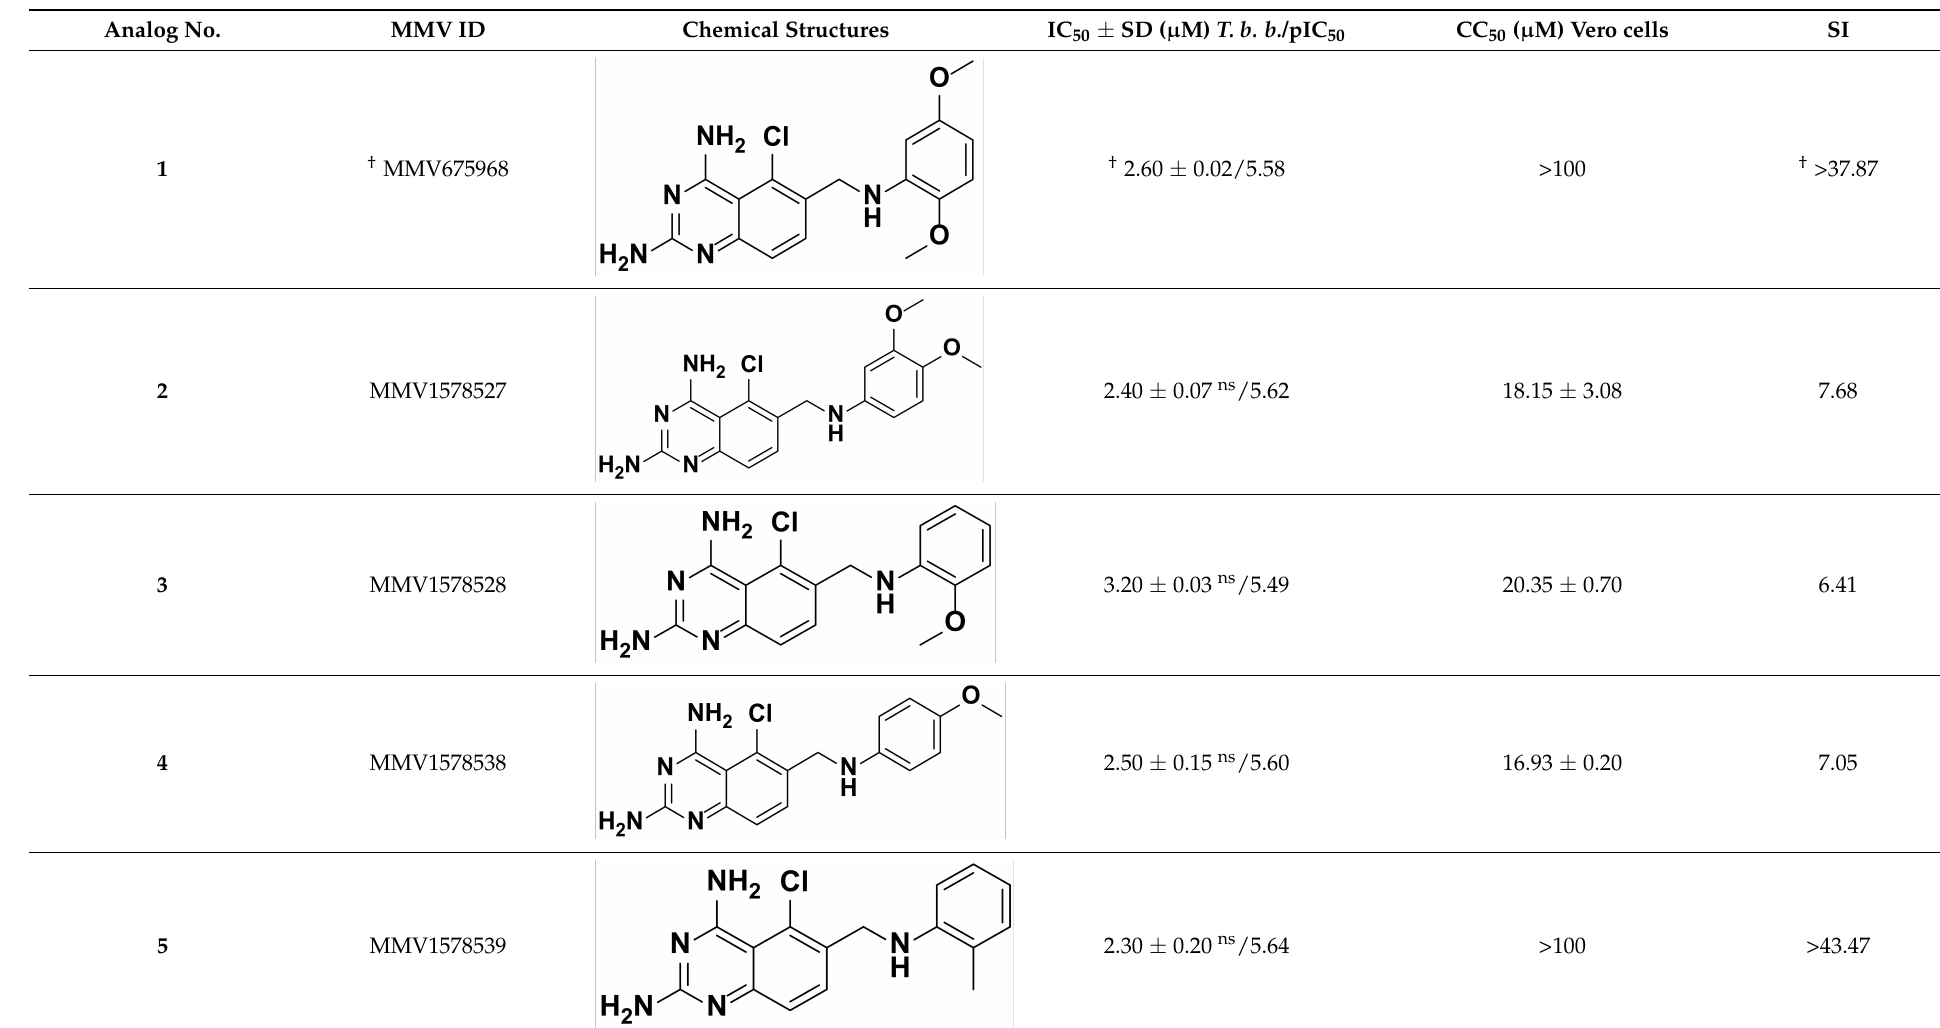
Table 4. Preliminary SAR study of 5-chloro-2,4-diaminoquinazoline (MMV675968) analogs for improved antitrypanosomal activity and selectivity. Analog